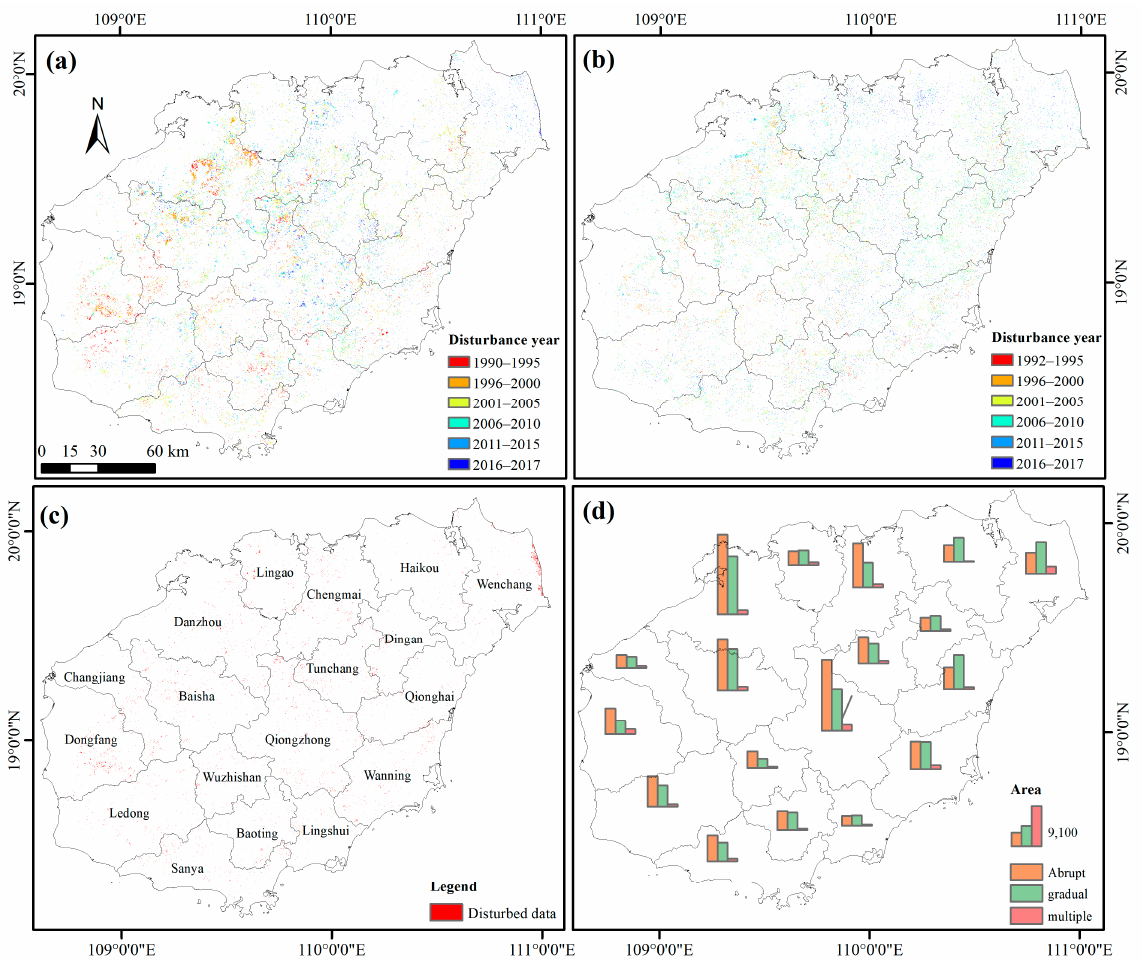
Figure 7. Spatial distributions of forest disturbances on Hainan Island from 1990 to 2020: ( a ) abrupt disturbances, ( b ) gradual disturbances, ( c ) multiple disturbances, and ( d ) areas of different disturbance types at city and county levels.